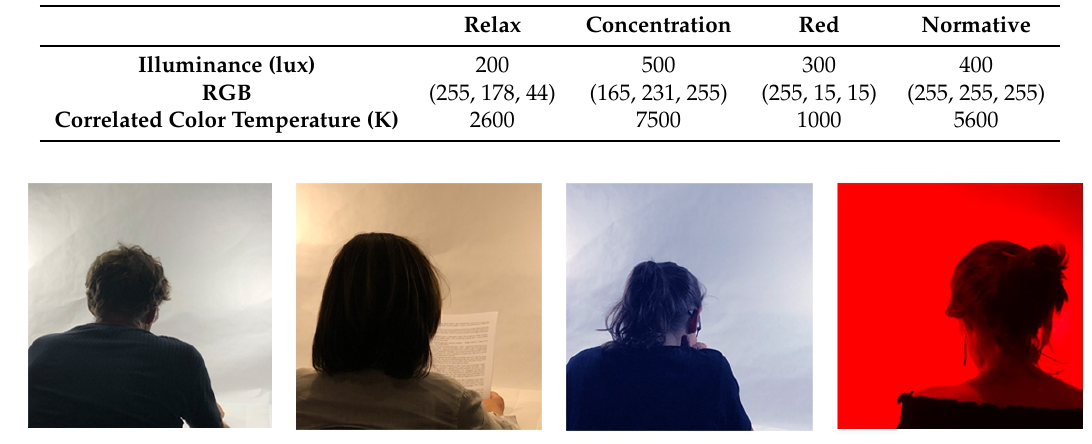
Figure 10. The four light conditions: “Normative”, “Relax”, “Concentration” and “Red”.